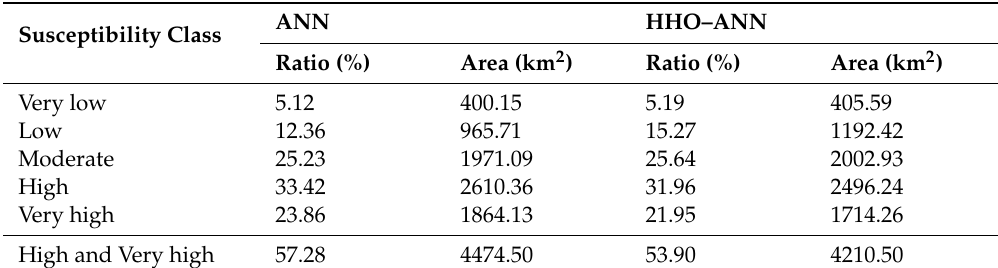
Table 3. The ratio and area of each susceptibility class.